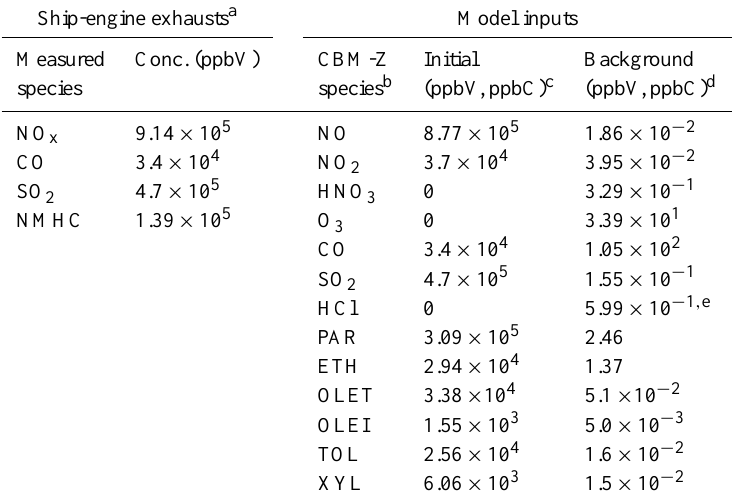
Table 2. Gas phase initial and background conditions.